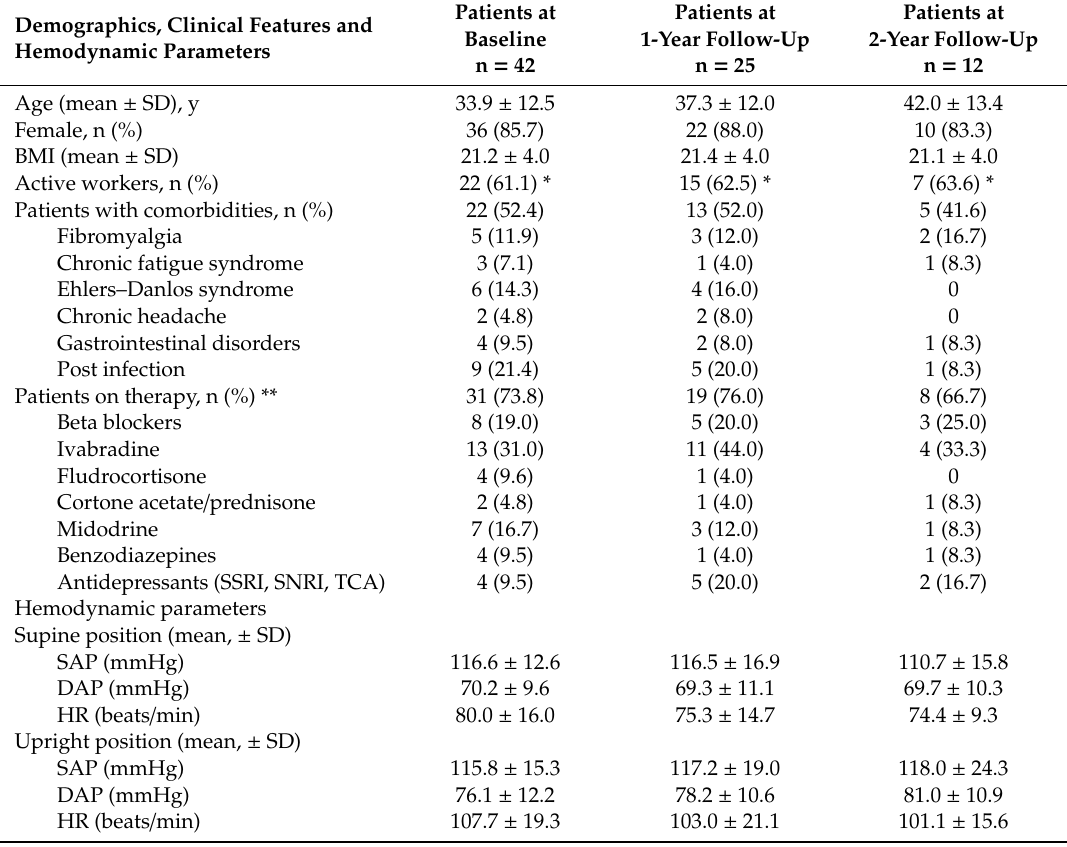
Table 1. Demographic and clinical features of the study population.